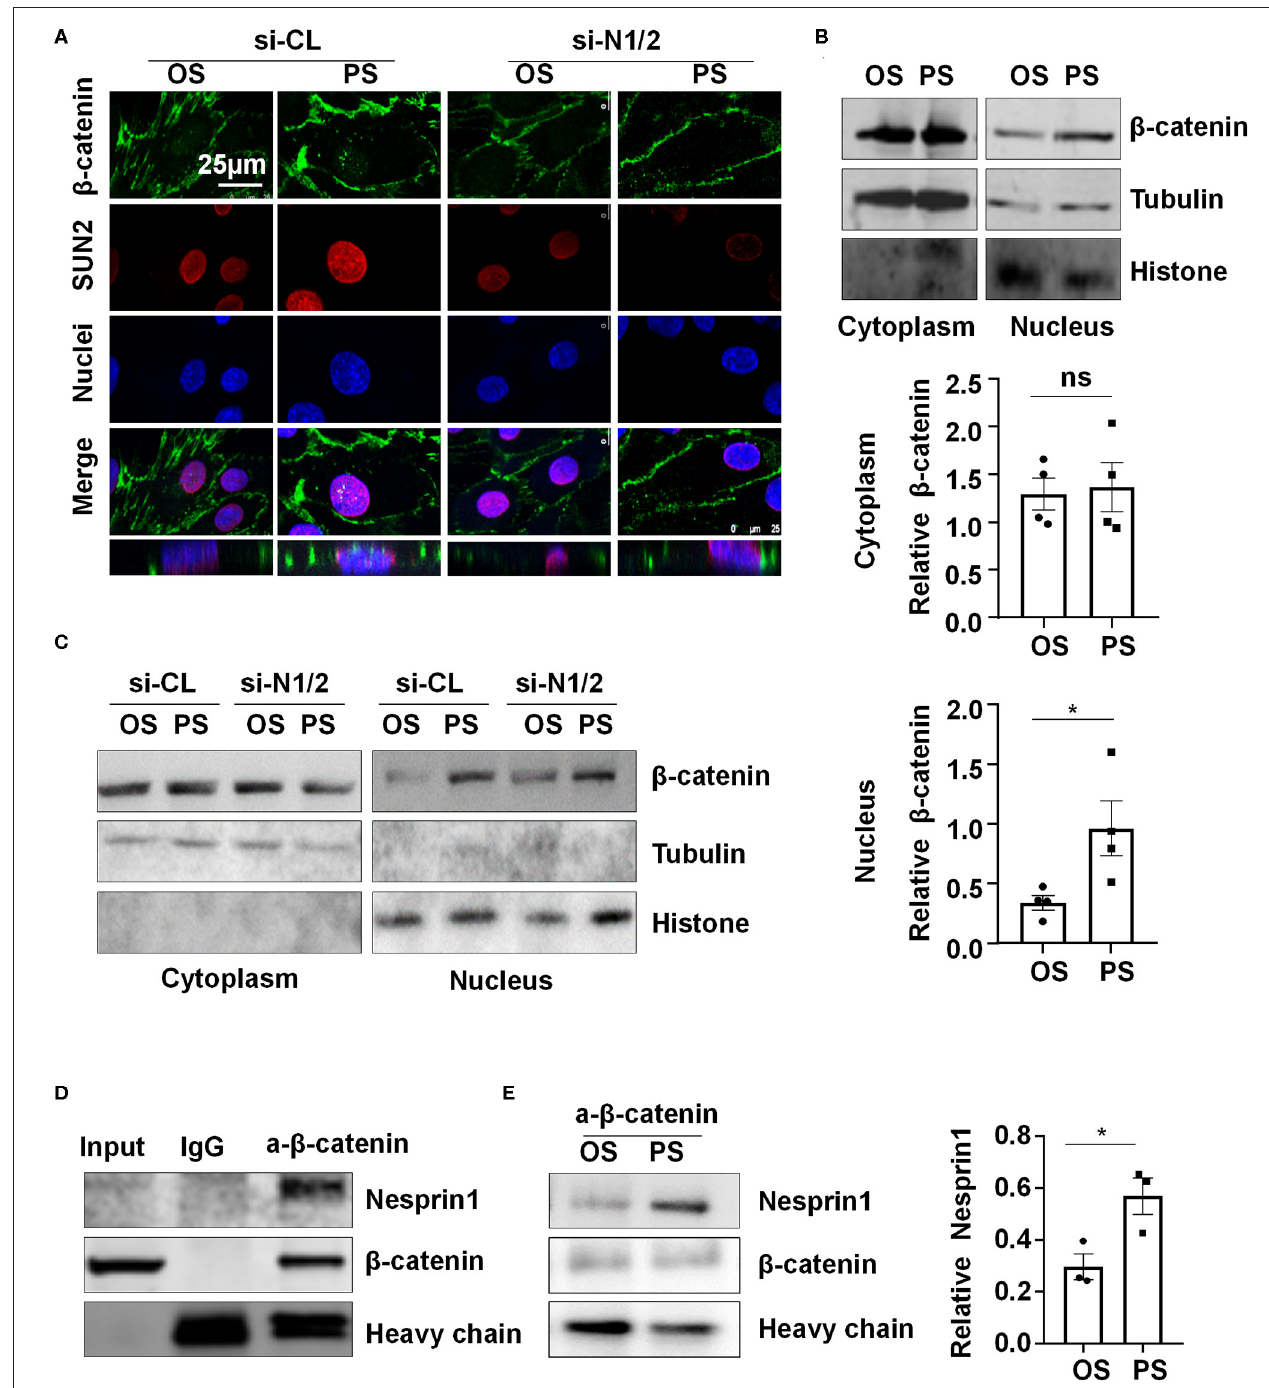
FIGURE 5 | Pulsatile shear (PS) enhances the association between Nesprin1 and β -catenin to facilitate a nuclear access of β -catenin. (A) HUVECs were transfected with siRNAs targeting Nesprin1 and Nesprin2 (si-N1/2) (60 nmol/L) or control siRNA (si-CL) and were then exposed to PS or OS for 6h, and the localizations of β -catenin (green) and SUN2 (red) were analyzed by immunofluorescence staining. The lower panels show 3D immunofluorescence re-construction, indicating β -catenin located mainly in cell-cell junctions and occasionally in the nuclei. (B,C) HUVECs with or without transfection were exposed to PS or OS and the nuclear and cytoplasmic fractions of the cells were separated to be subjected to Western blot. In (B) , semi-quantification of the blots are shown in the lower panels. (D,E) The association of Nesprin1 with β -catenin was analyzed with co-immunoprecipitation assay in static (D) or sheared HUVECs (E) . Statistical analysis of (B,E) were performed by unpaired t -test. * P < 0.05 compared with the indicated controls.